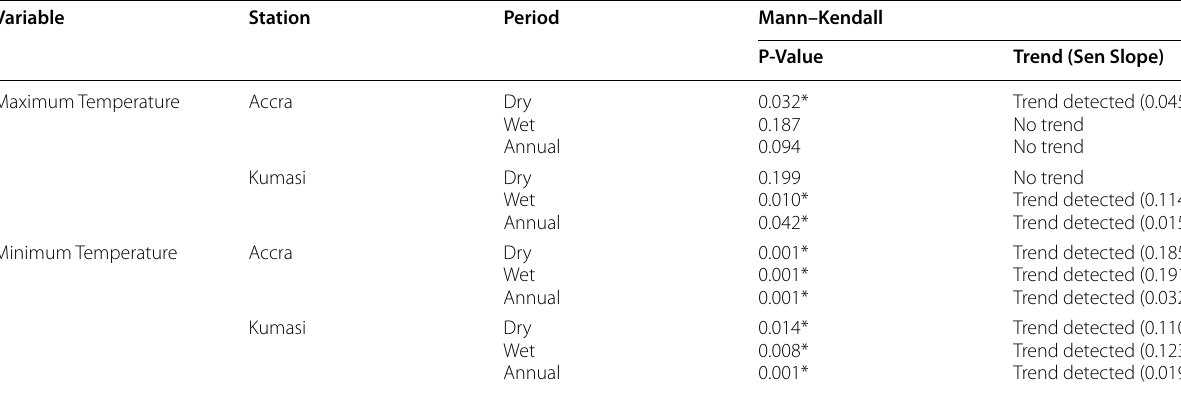
*Statistically significant trends at 5% significance level